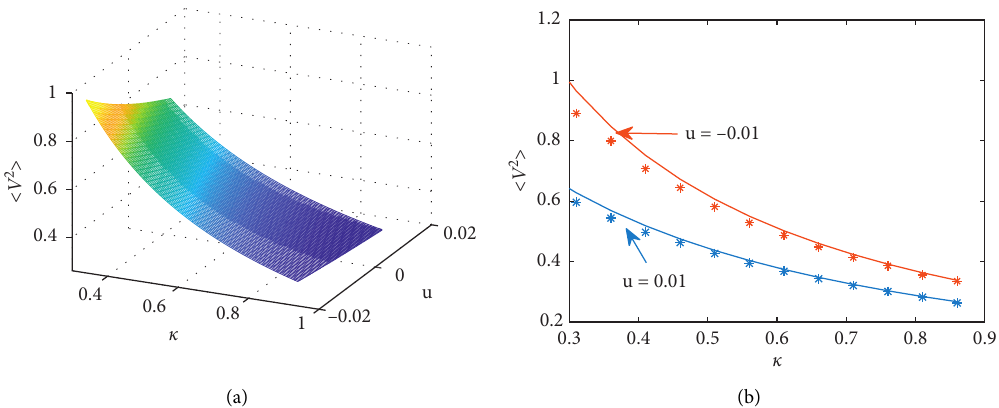
Figure 8: The influences of piezoelectric coupling coefficient and feedback strength on the MSEV. Theoretical analysis results (solid line) and Monte Carlo simulation results ( ∗